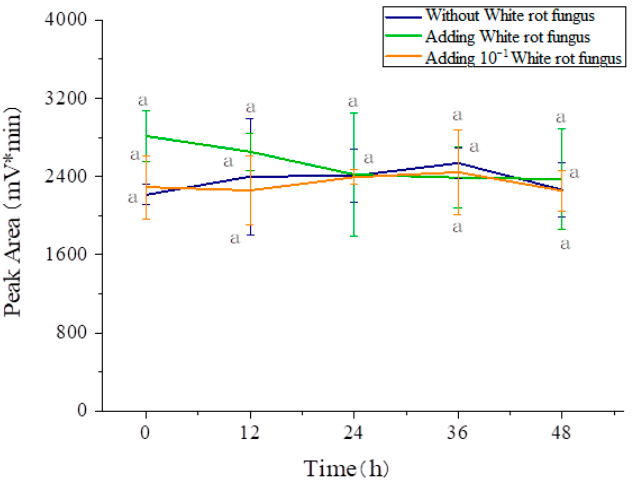
Figure 6. Effect of colony numbers of white rot fungus on the degradation of amygdalin.